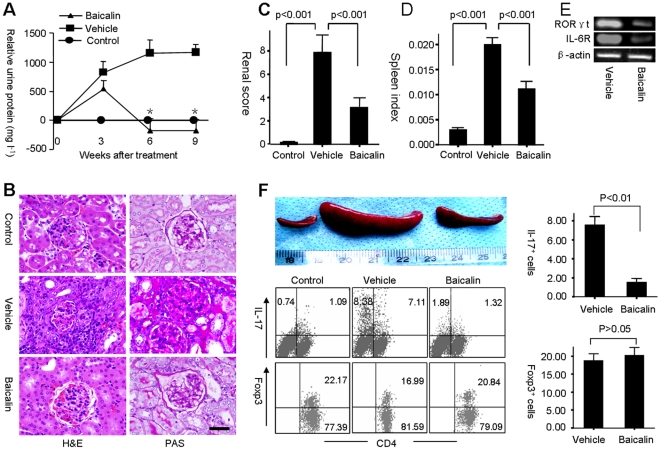
Baicalin inhibits TH17 cell differentiation in vivo.(A) MRL/lpr mice were treated with Baicalin or vehicle for 9 weeks, B6 mice (control) were treated with vehicle. Relative urine protein increases  =  urine protein (mg/L) at indicated time point - urine protein (mg/L) of week 0 (n = 6 for each group). In the comparison between Baicalin- and vehicle-treated mice, the asterisk indicates p<0.001. (B) Histopathology of kidneys. Hematoxylin and eosin staining (H&E, left) and periodic acid-Sciff-staining (PAS, right). Scale bar, 100 µm. (C) The renal score of control and MRL/lpr mice (n = 6 for each group). (D) Spleen index of control and MRL/lpr mice (n = 6 for each group). (E) IL-6R and RORγt mRNA levels in spleen cells of MRL/lpr mice were analyzed by RT-PCR. (F) The percentages of IL-17+ and Foxp3+ cells among CD4+ T cells of spleen cells isolated from MRL/lpr mice were determined by flow cytometry analysis. (n = 6 for each group). Results were expressed as mean ± SD. Spleens were shown.